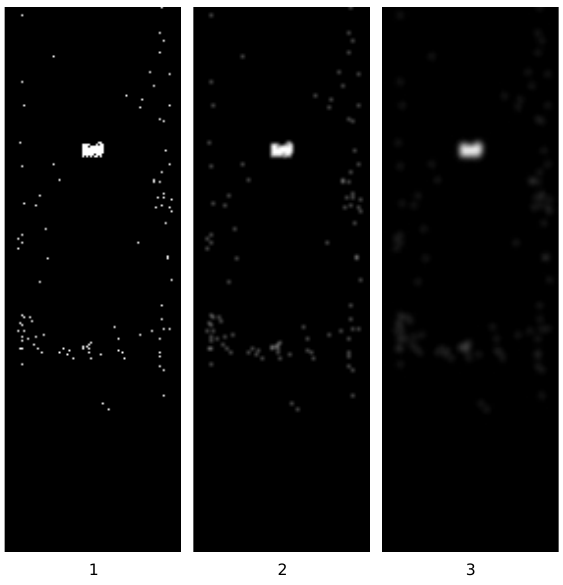
Figure 7. Three identical frames with no Gaussian filtering in frame 1, minimal Gaussian filtering in frame 2 and for the project’s obstacle detection best Gaussian filtering settings in frame